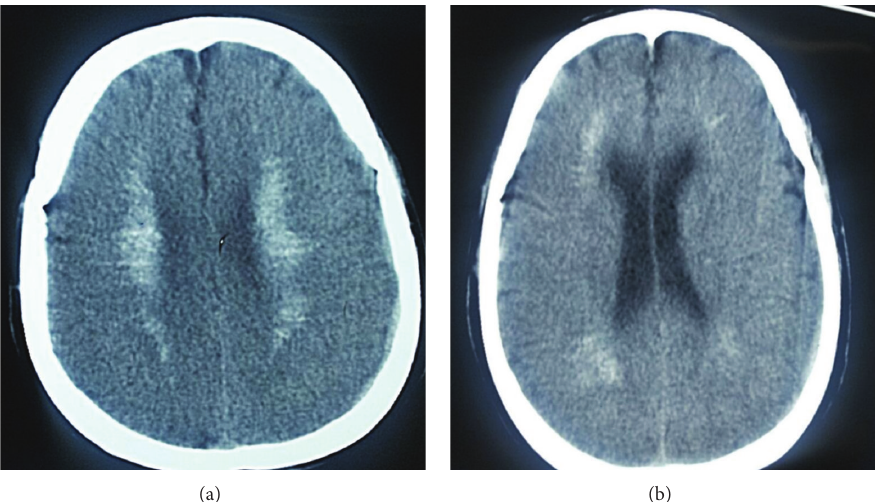
Figure2:Noncontrastcomputedtomographyofthebrainshowedintracranialcalcificationinvolvingthebasalganglia,thalamus,andcerebral cortex on both the right (b) and left (a) sides.